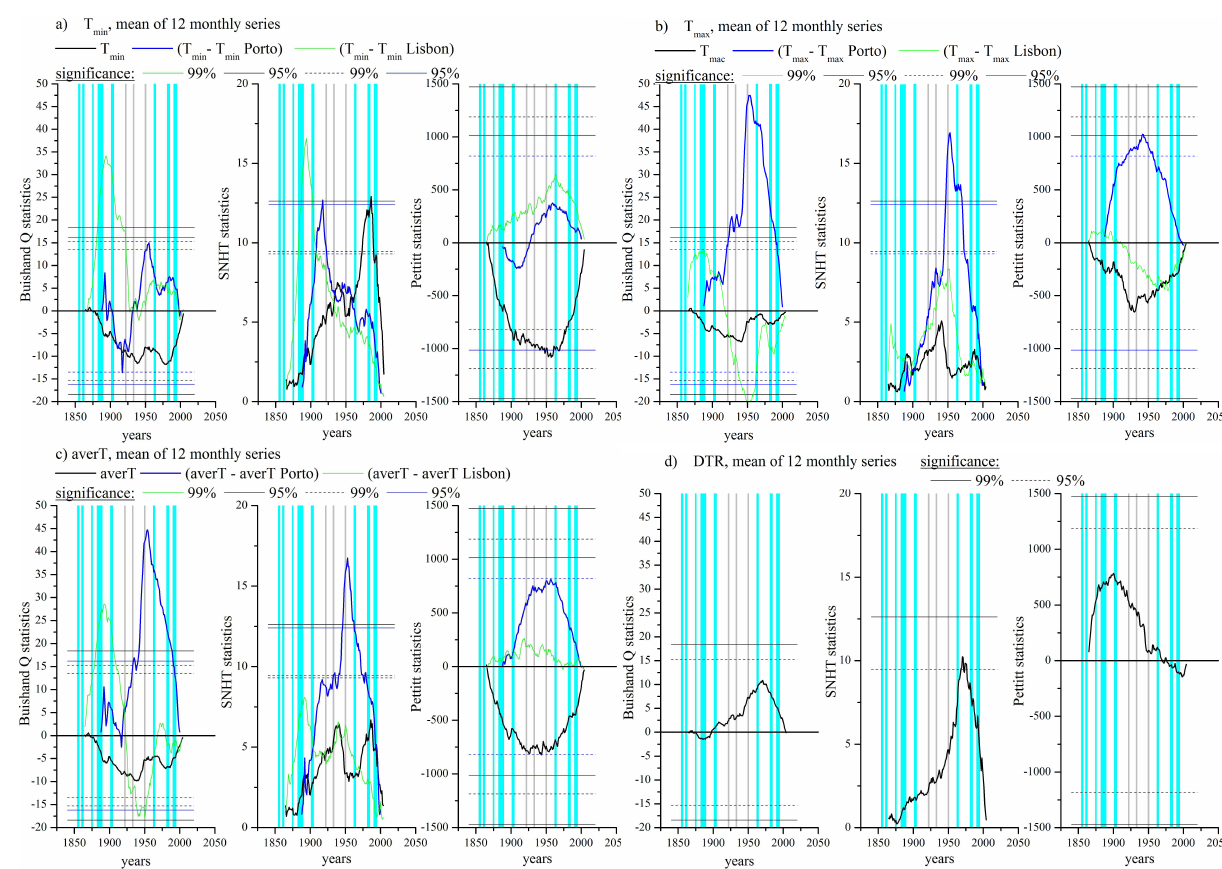
Figure 25. Coimbra: same as Fig. 21 but for the corrected